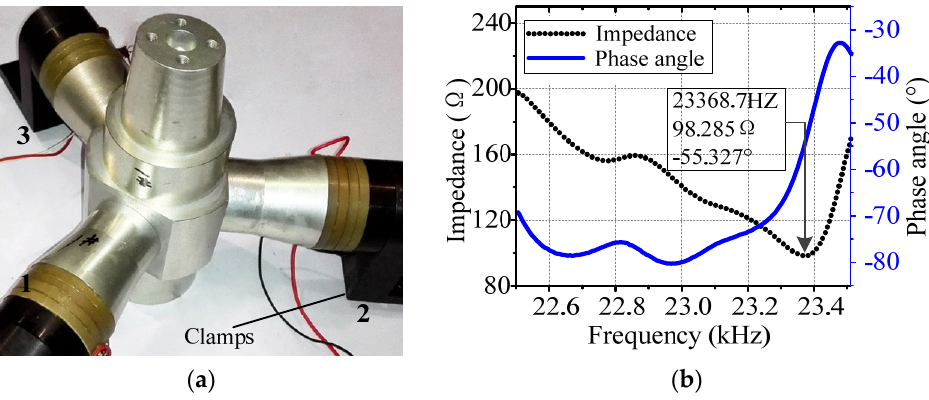
Figure 13. Assembled manufactured power-superimposed vibrator and its impedance test results. ( a ) Assembled manufactured vibrator. ( b ) Impedance test results.